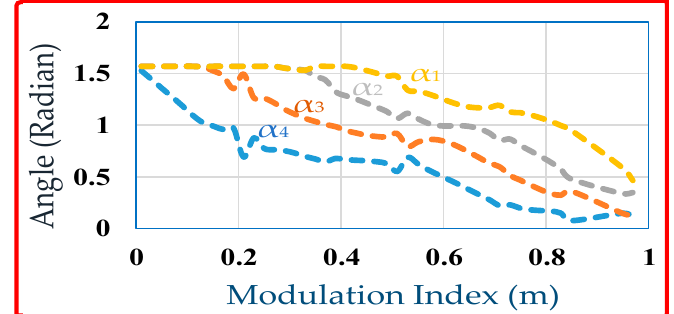
Figure 7. Firing angle (radian) versus modulation index (m) in PEC − 9. Table 3. MATLAB parameter simulation.